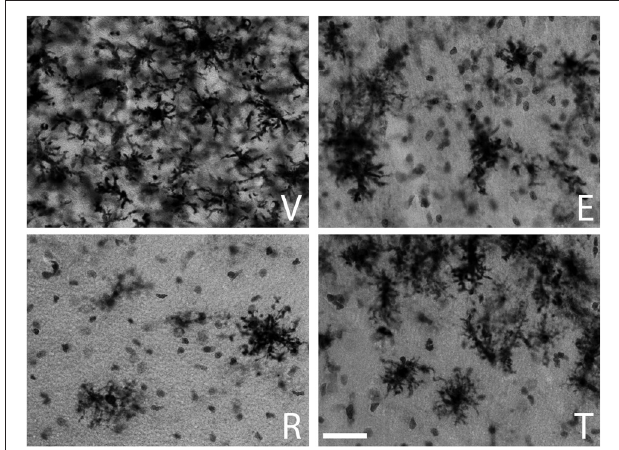
FIGURE 1 | MHC-II immunoreactive microglia in the CA1 stratum radiatum at a distance of approximately 100–200 µ m from the lateral border of the wound in young animals . The panels illustrate representative examples from ovariectomized young rats after administration of (V) vehicle, (E) estradiol, (R) raloxifene or (T) tamoxifen. All figures are at the same magnification. Scale bar, 50